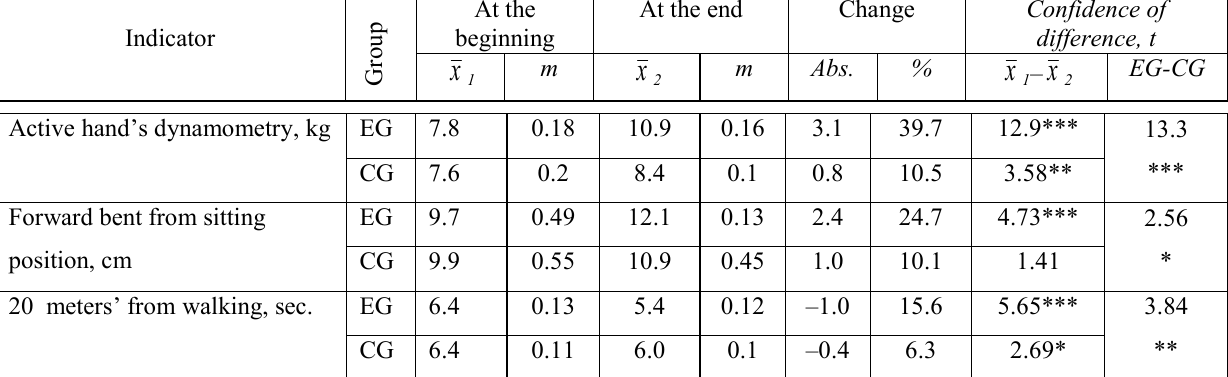
At the At the oup beginning G r